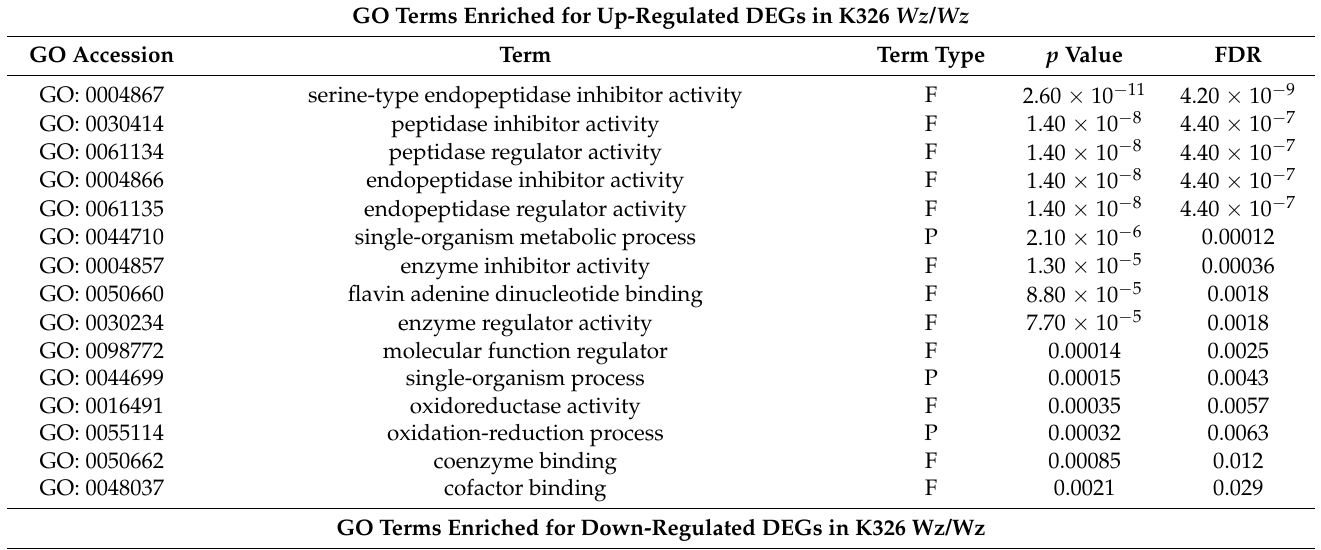
Table 10. GO terms enriched for DEGs identified in K326 Wz / Wz across inoculations using the Wz-Wz and Wz -H isolates. GO Terms Enriched for Up-Regulated DEGs in K326